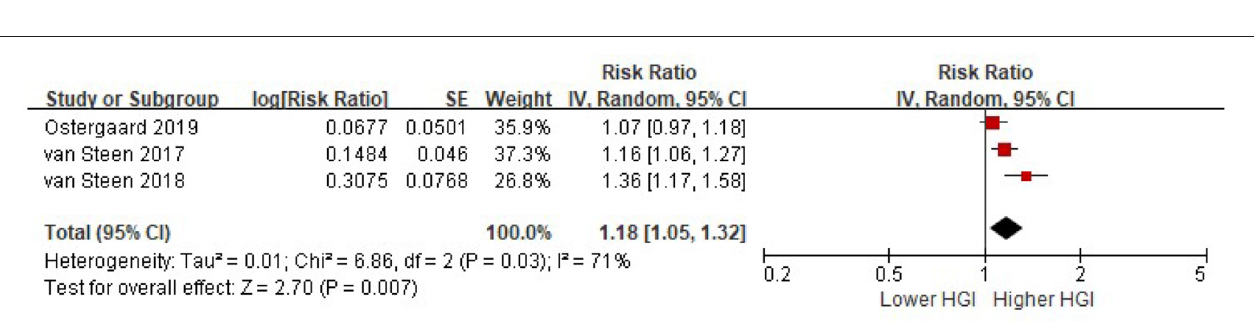
FIGURE 2 | The association between HGI and the risk of composite CVD. Data were presented as the HR and 95% CI of composite CVD for per 1 SD increment of HGI, after adjusting for multiple cardiovascular risk factors (without HbA1c). CI, confidence interval; CVD, cardiovascular disease; HGI, hemoglobin glycation index.